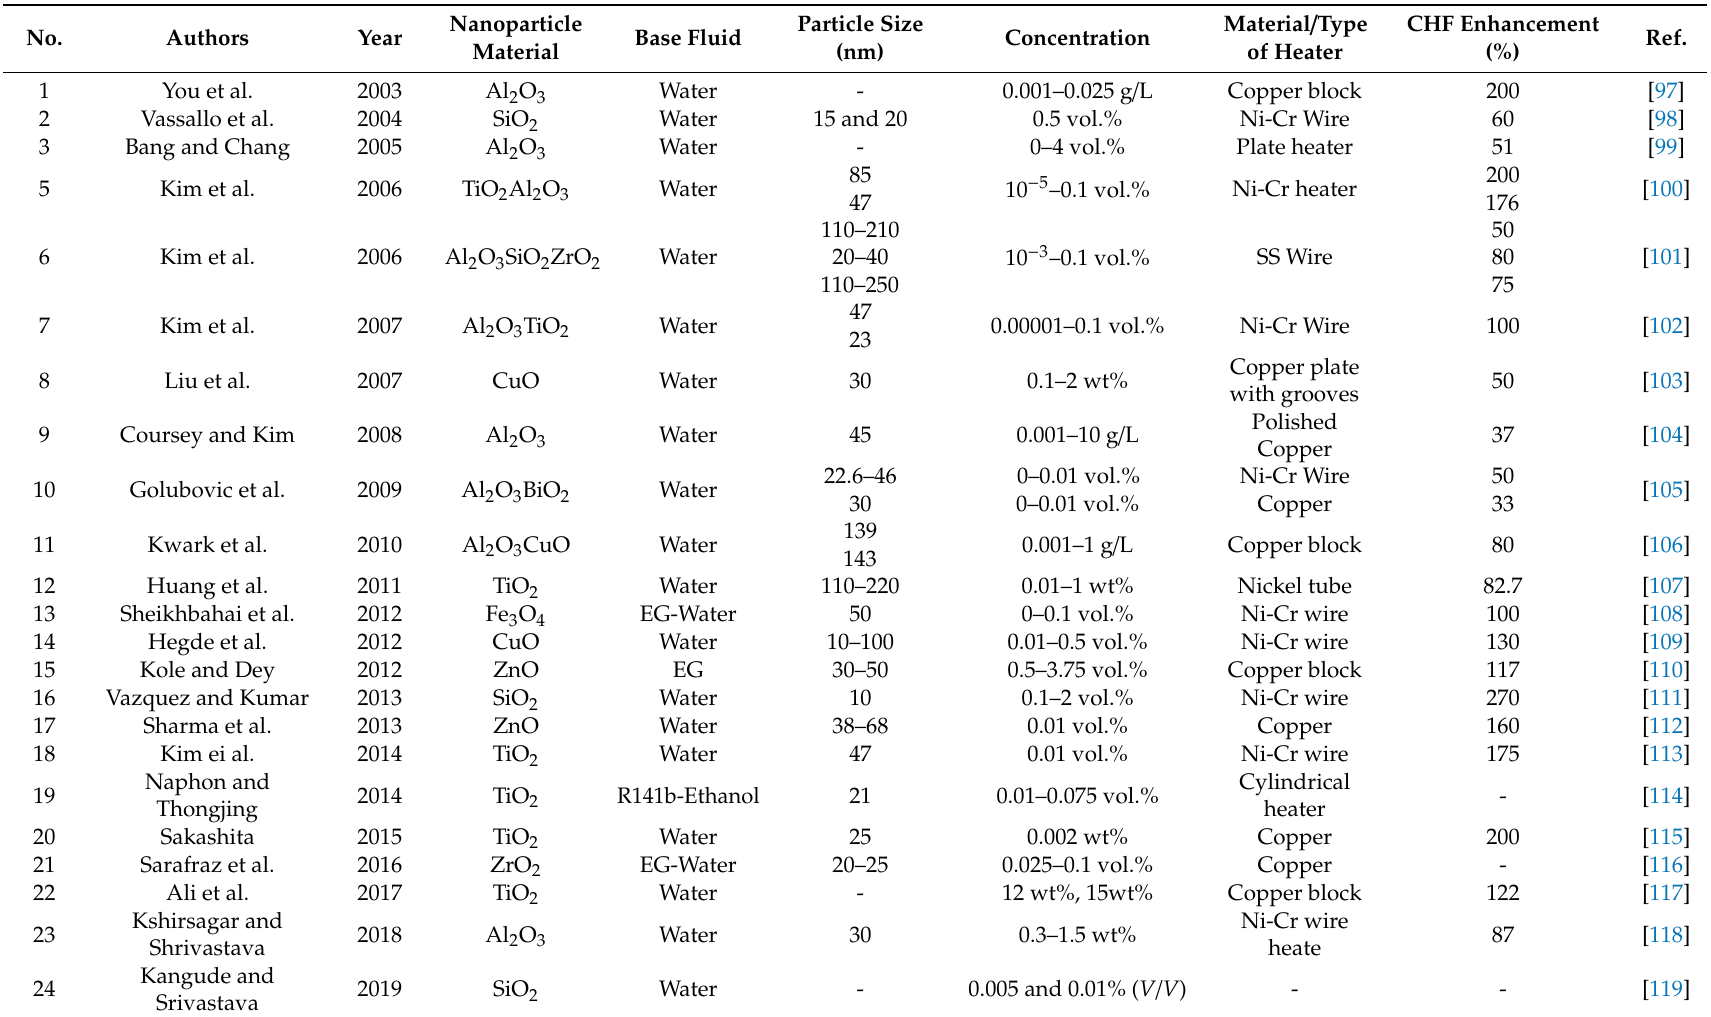
Table 1. Summary of critical heat flux (CHF) amelioration for selected pool boiling